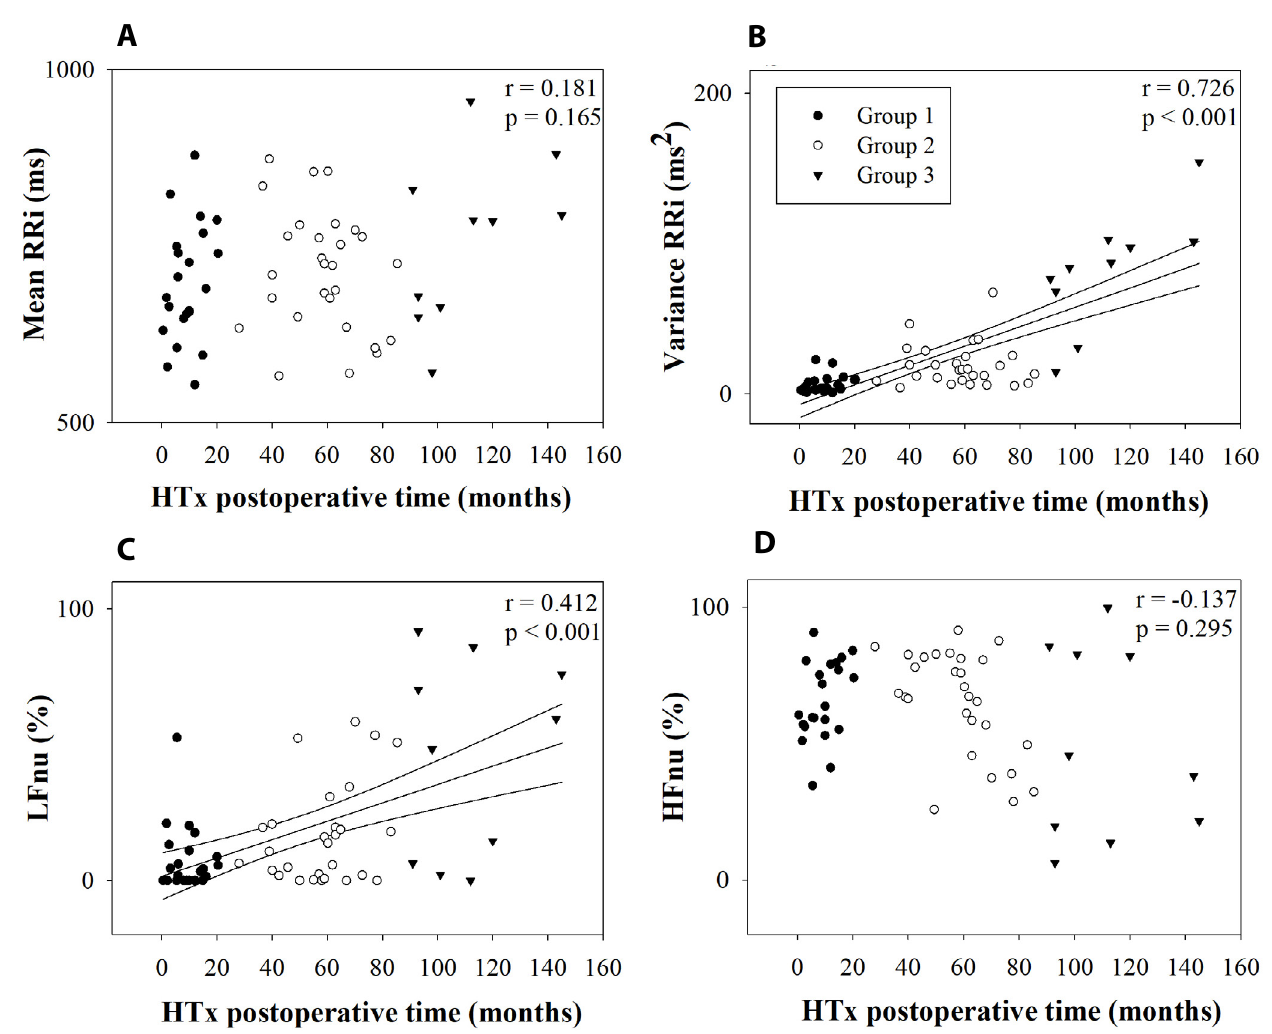
Fig. 2 – Relation between linear analysis and heart transplantation (HTx) postoperative time. Linear regression and its 95% confidence interval of variance (B) and low frequency in normalized unit (LFnu) (C). Group 1 is represented by l , Group 2 is represented by O , and Group 3 is represented by q . HFnu=high frequency in normalized units; LFnu=low frequency in normalized units; RR=R–R